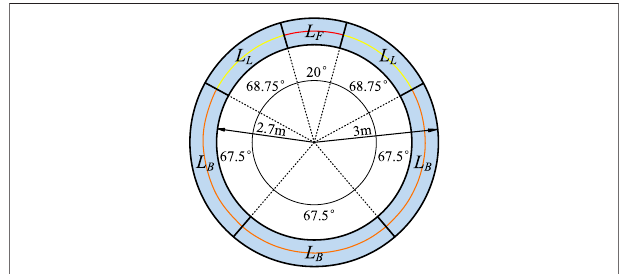
FIGURE 5 | Schematic diagram of shield lining structure.